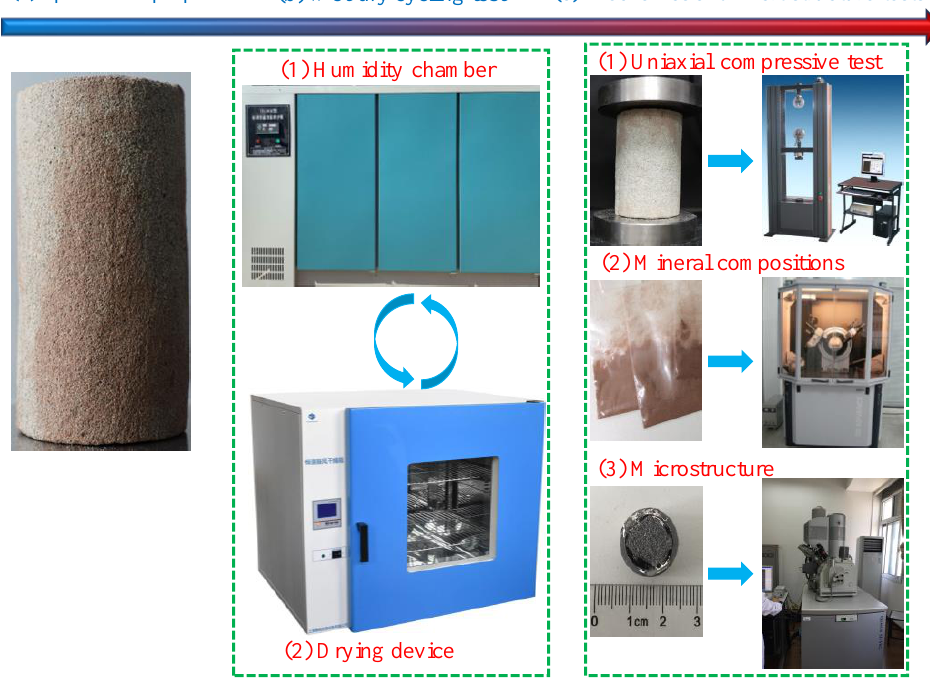
Figure 14. Procedure of the wet – dry cycle test.